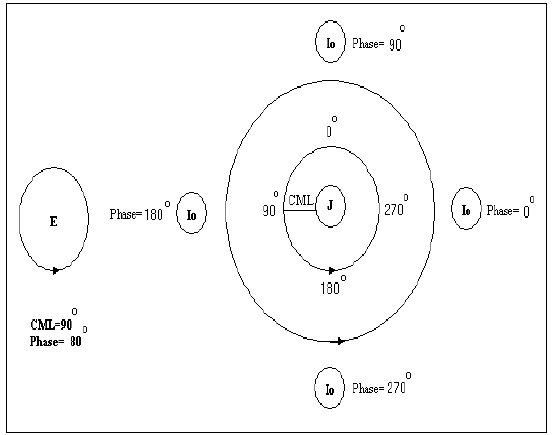
of Jupiter and ІІІ